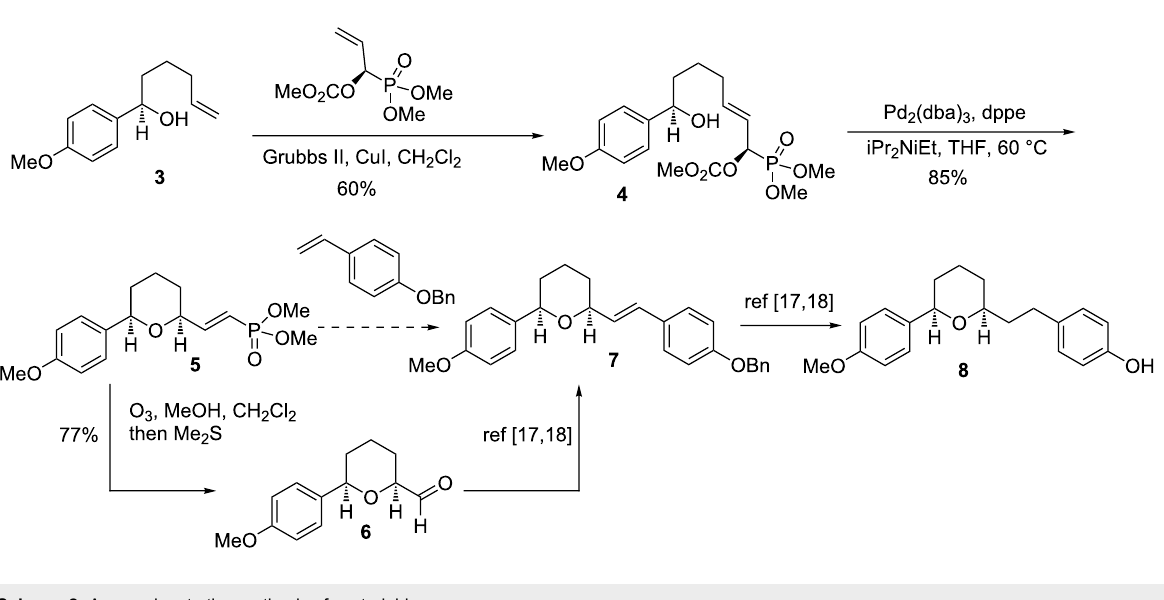
Scheme 2: Approaches to the synthesis of centrolobine.